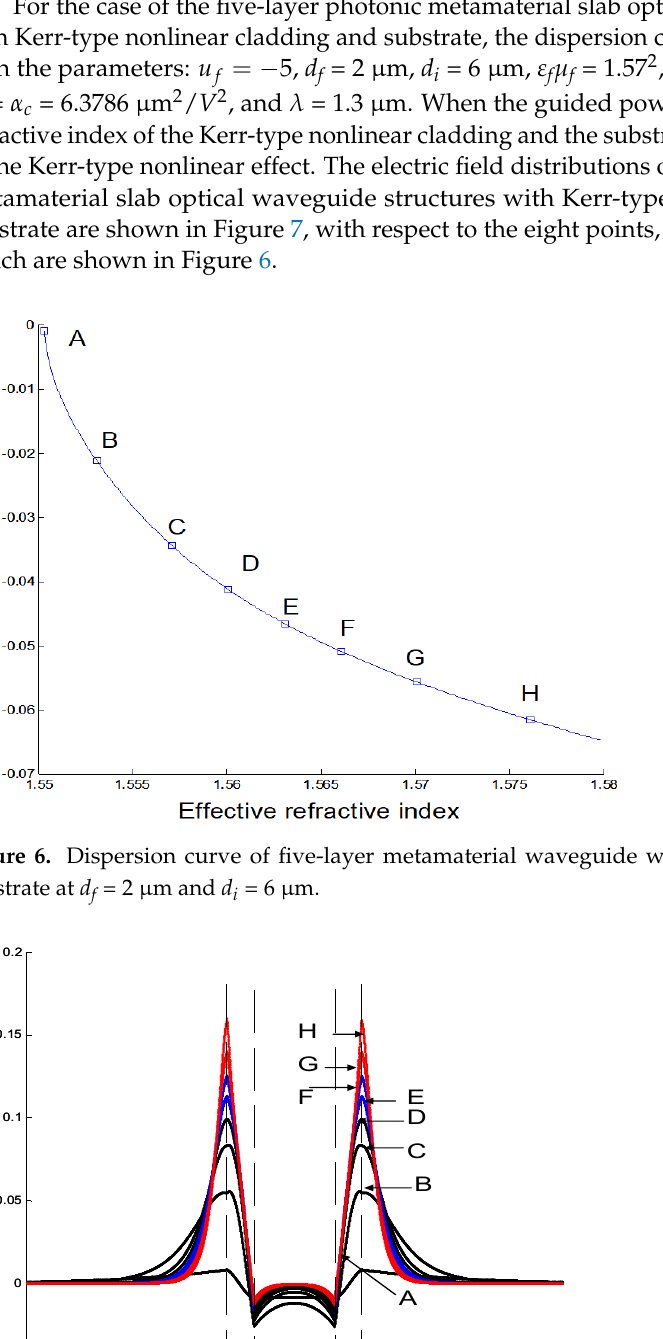
Figure 5. The electric field distributions with respect to the six points, A, B, C, D, E, and F, shown in Figure 4.